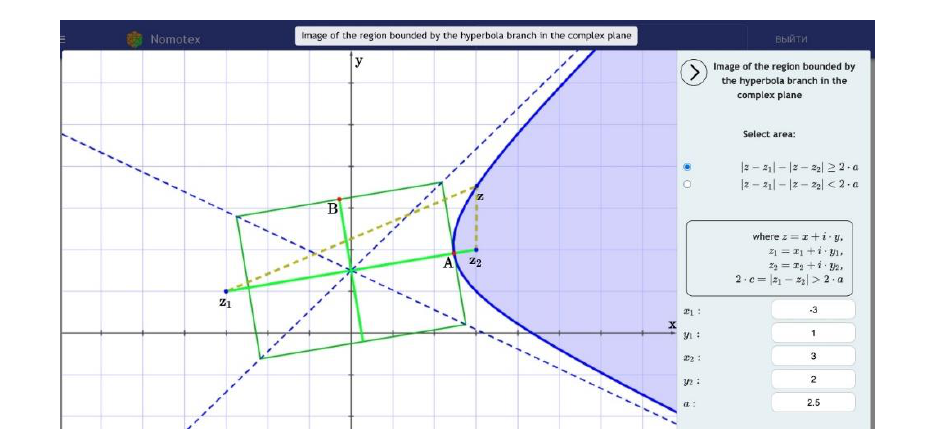
Fig. 3. Example of visualization in DLS NOMOTEX.